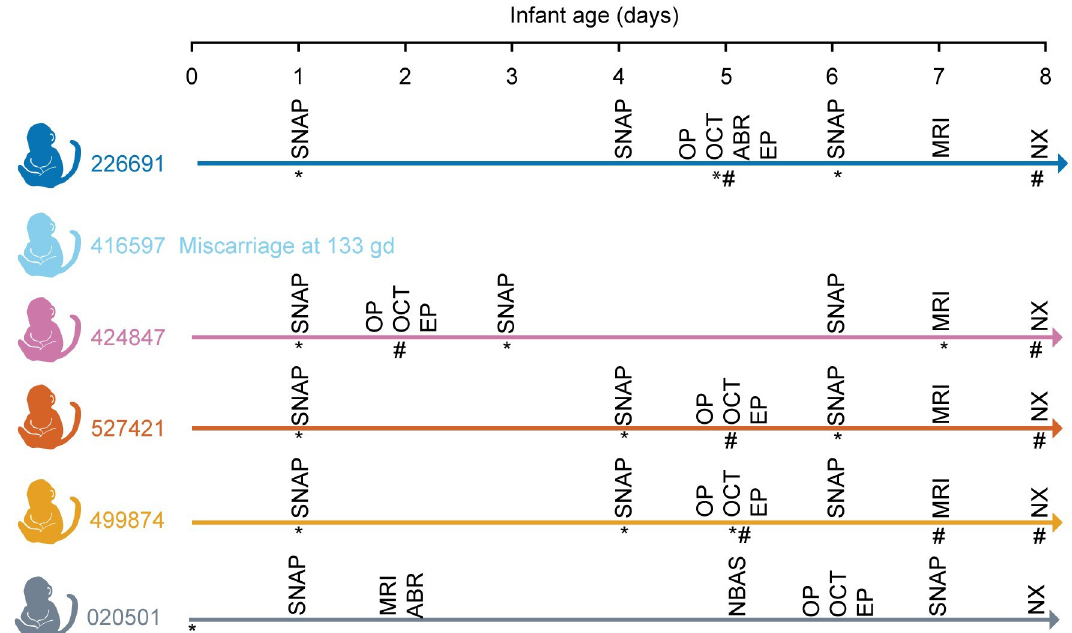
Fig 1. Infant examination schedule. Infants were evaluated by the Schneider Neonatal Assessment for Primates (SNAP), ophthalmic exam (OP), optical coherence tomography (OCT), auditory brainstem response (ABR), visual electrophysiology (EP) and brain MRI prior to euthanasia and necropsy (NX). Urine ( � ) and blood (#) were collected at the indicated times. Symbols are under the collection line for an individual